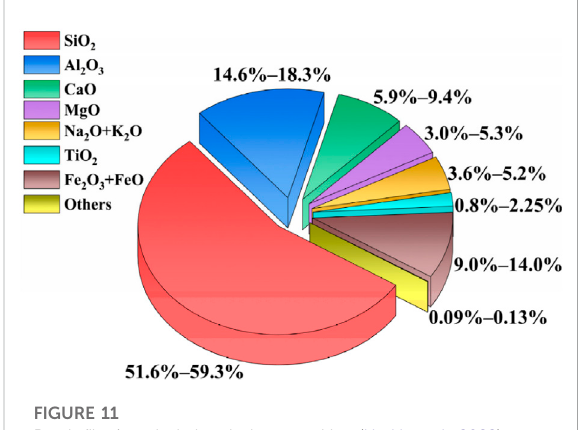
Basalt fi ber ’ s typical chemical composition (Liu H. et al., 2022).